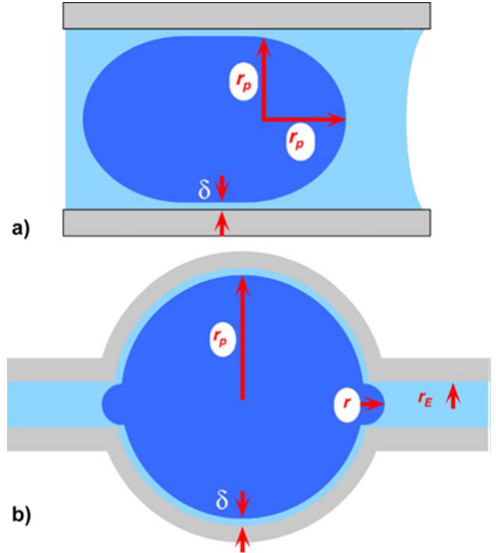
Figure 1. If the crystal grows in a cylindrical pore with radius (cid:1870) (cid:3043) , then the end of the crystal is hemispherical and has curvature (cid:2018) (cid:3004)(cid:3013)(cid:3006) (cid:3404) 2/(cid:3435)(cid:1870) (cid:3043) (cid:3398) (cid:2012)(cid:3439) , whereas the cylindrical side has curvature (cid:2018) (cid:3004)(cid:3013)(cid:3020) (cid:3404) crystal and the pore wall. (b) When a crystal grows in a large pore (r p macroscopic) with small entries (radius (cid:1870) (cid:3006) ≪ (cid:1870) (cid:3043) ), the curvature